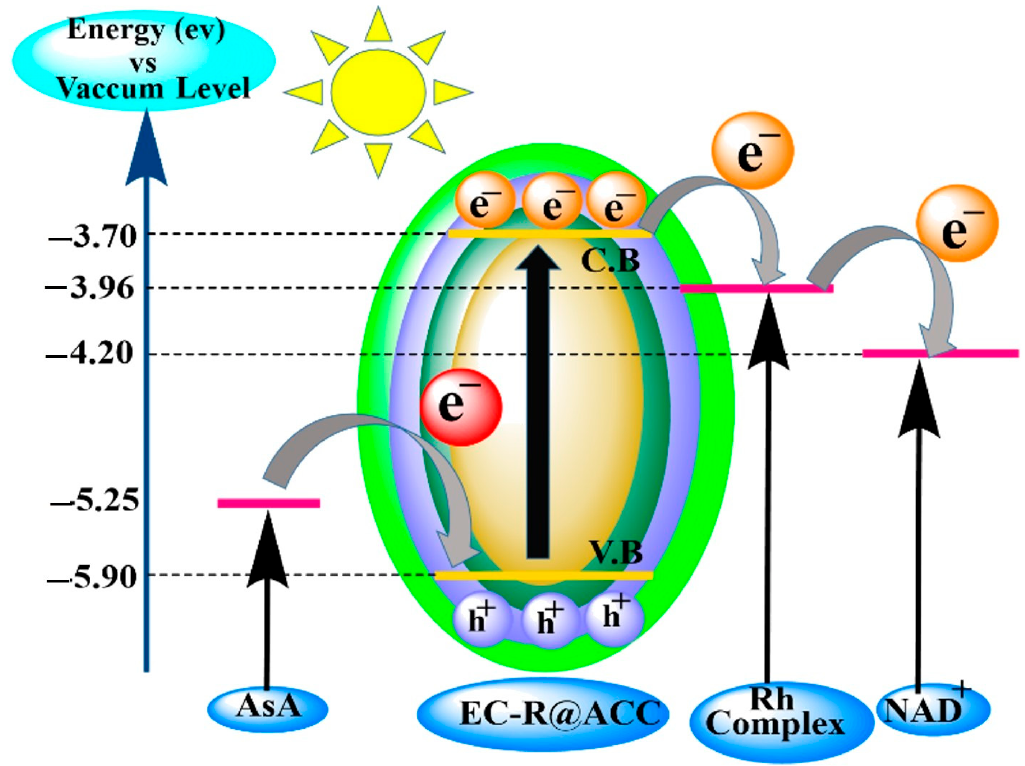
Scheme 5. A simpli fi ed potential energy diagram showing carrier generation and its migration in the photocatalytic